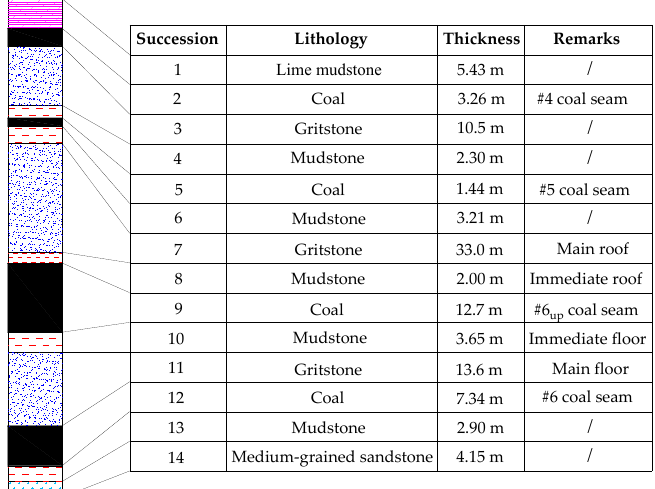
Figure 2. Stratigraphic column of first mining zone.